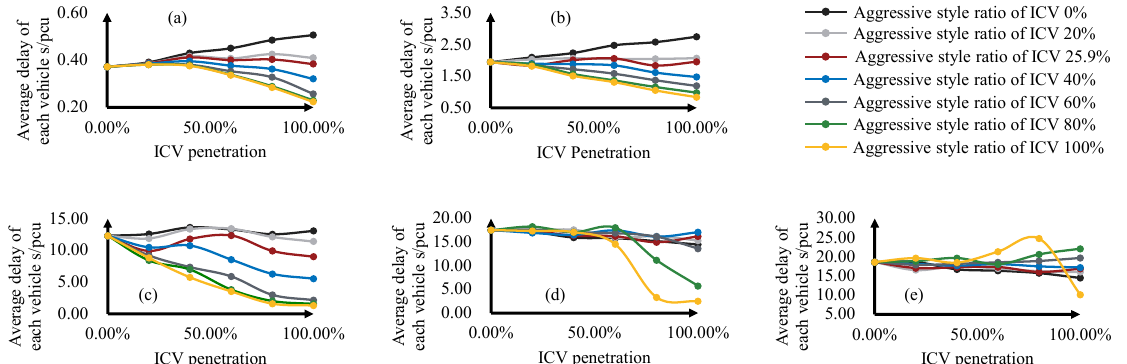
Figure 4. The impacts of SLADS on traffic delay on the expressway under different driving styles with the volume input being equal to the first service level ( a ), the third service level ( b ), the saturated service level ( c ), the 20% ( d ) and 40% ( e ) oversaturated service level.